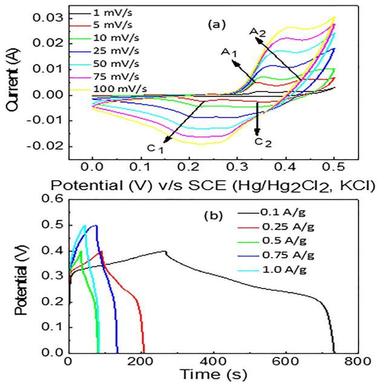
(a) CV curves recorded at different scan rates, and (b) GCD curves recorded at different current densities for the fabricated Zn0.1Co2.9O4 electrode.